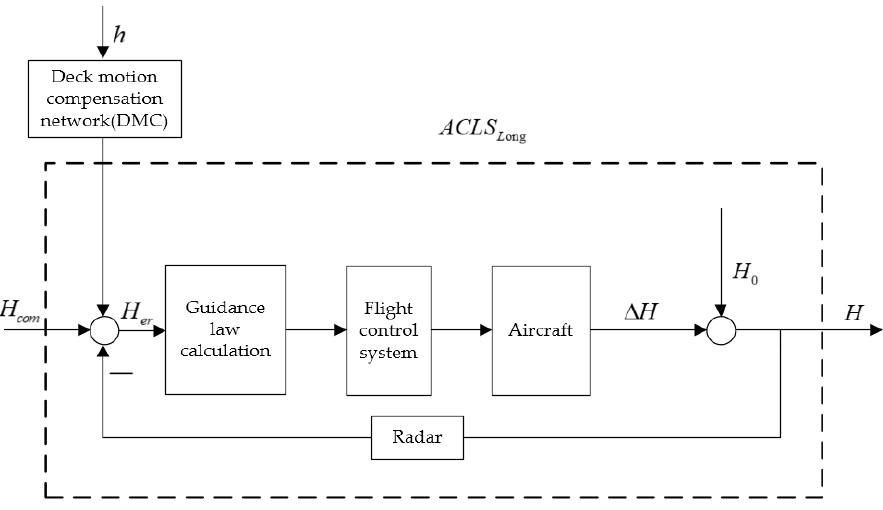
Figure 10. The structure of the longitudinal automatic landing guidance system with deck motion compensator.